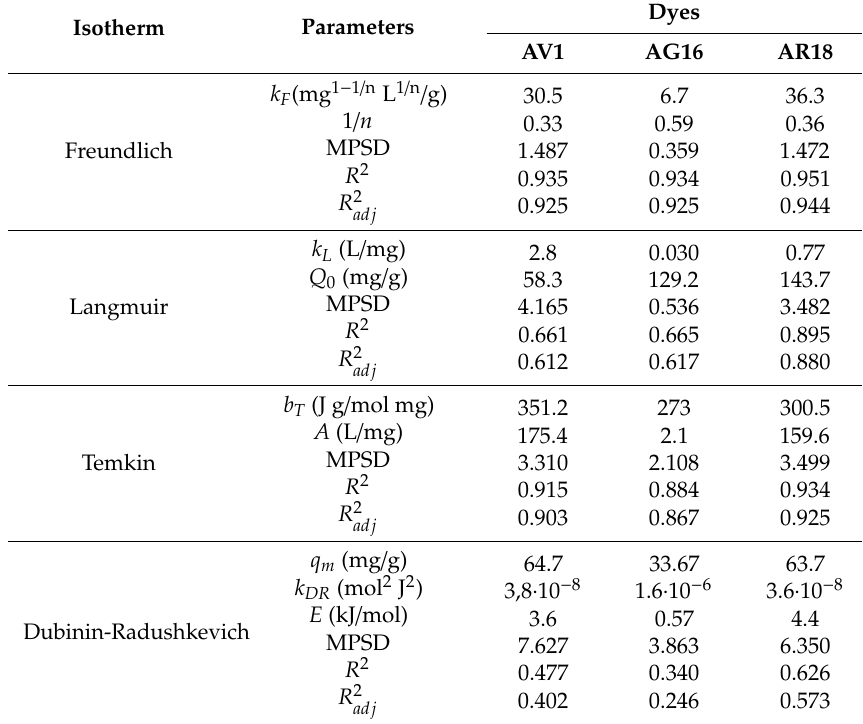
Table 3. Values of parameters calculated in terms of isotherm models